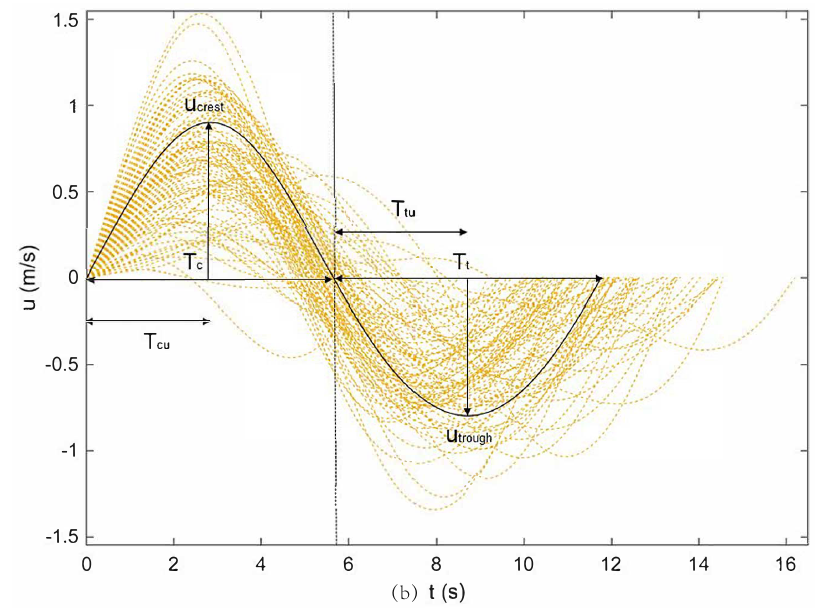
Figure 2. ( a ) Raw ( u raw ) and filtered incident wave band ( (cid:101) u incident ) spectra for a representative burst time series during the 14 February 2014, storm event in the Fire Island dataset, ( b ) individual waveforms (dashed lines) and the representative waveform (solid line) for the burst time